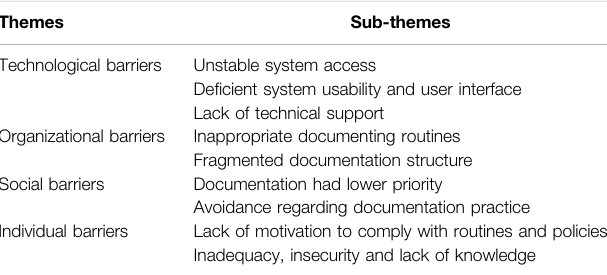
TABLE 1 | Themes and sub-themes describing barriers for patient